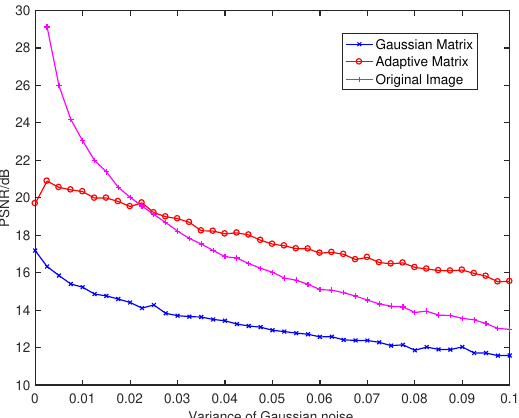
Figure 12. PSNR of image reconstructed from the original image added with Gaussian noise, which with a mean of 0 and different variance of 0.0–0.1 by using the adaptive matrix measure with the Gaussian random matrix and the adaptive matrix, the resolution of the image is all 64 × 64, and the reconstructed algorithm is